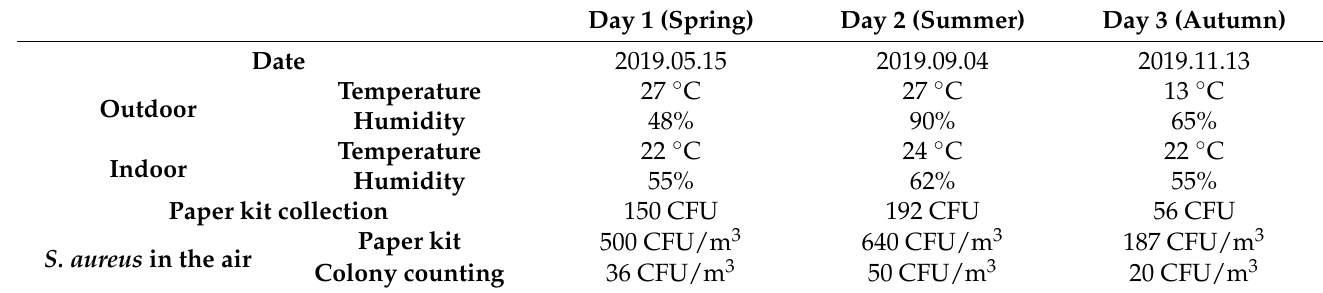
Table 1. Indoor air collection results. Each air collection procedure was conducted in Gwangju,